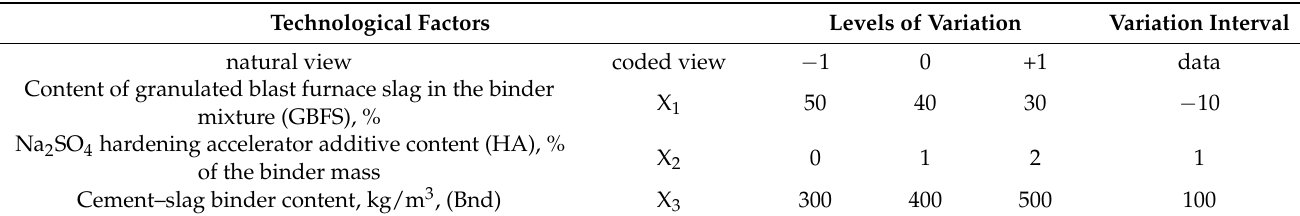
Table 3. Experiment planning